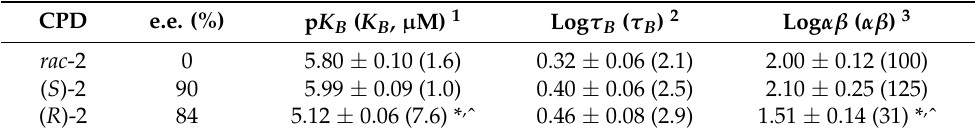
Table 1. Functional parameters for PAMs derived from cAMP BRET assay at the hD 1